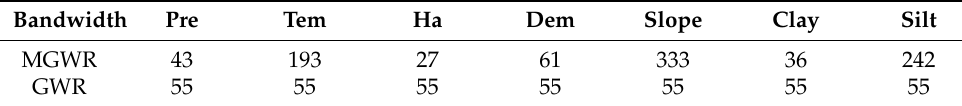
Table 6. Comparison of bandwidth between GWR and